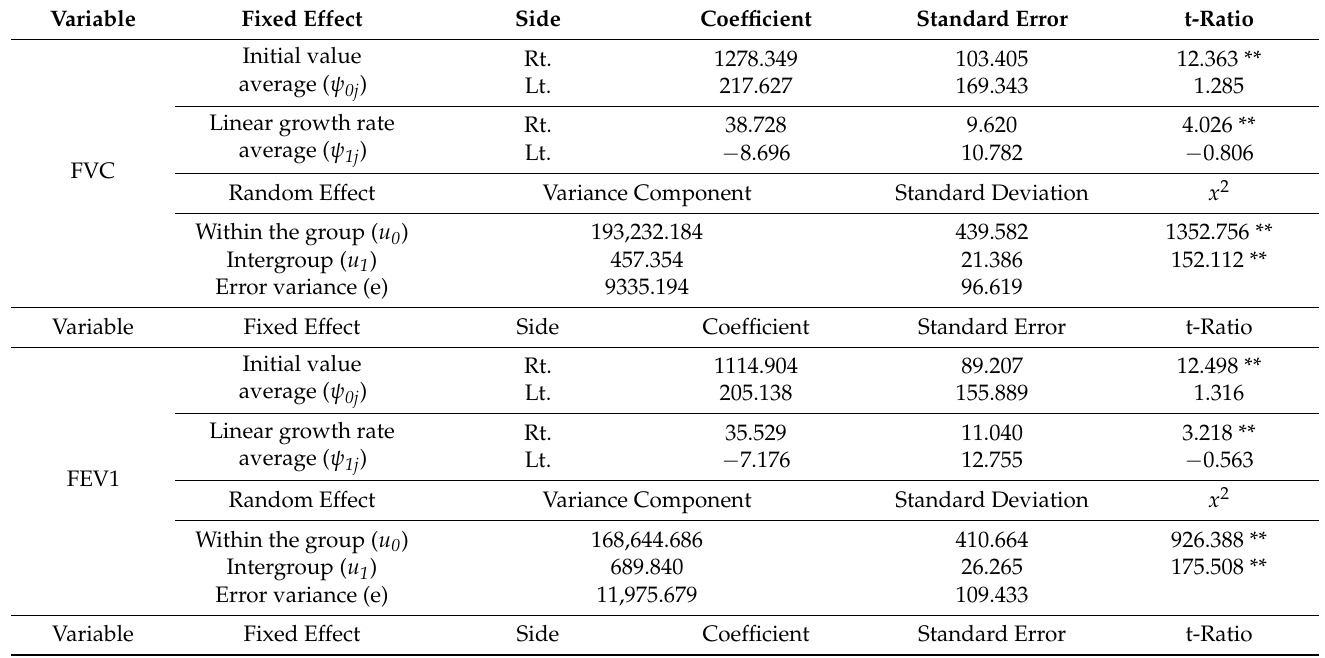
Figure 2. Initial value and ending value based on paralyzed side of hemiparetic stroke patients. Each solid line represents a respiration index value evolvement for one subject over 12 training sessions. The green dashed line represents the linear growth rate average of the right-sided paralysis group, the purple dashed line represents the linear growth rate average of the left-sided paralysis group, and the black dashed line represents the linear growth rate average of all stroke patients. ( A ) FVC, forced vital capacity; ( B ) FEV1, forced expiratory volume in the first second; ( C ) FEV1/FVC ratio, forced expiration ratio; ( D ) PCF, peak cough flow. Table 6. Changes in respiratory function exhibited by the entire group. Table 7. Changes in respiratory function based on paralyzed side of stroke